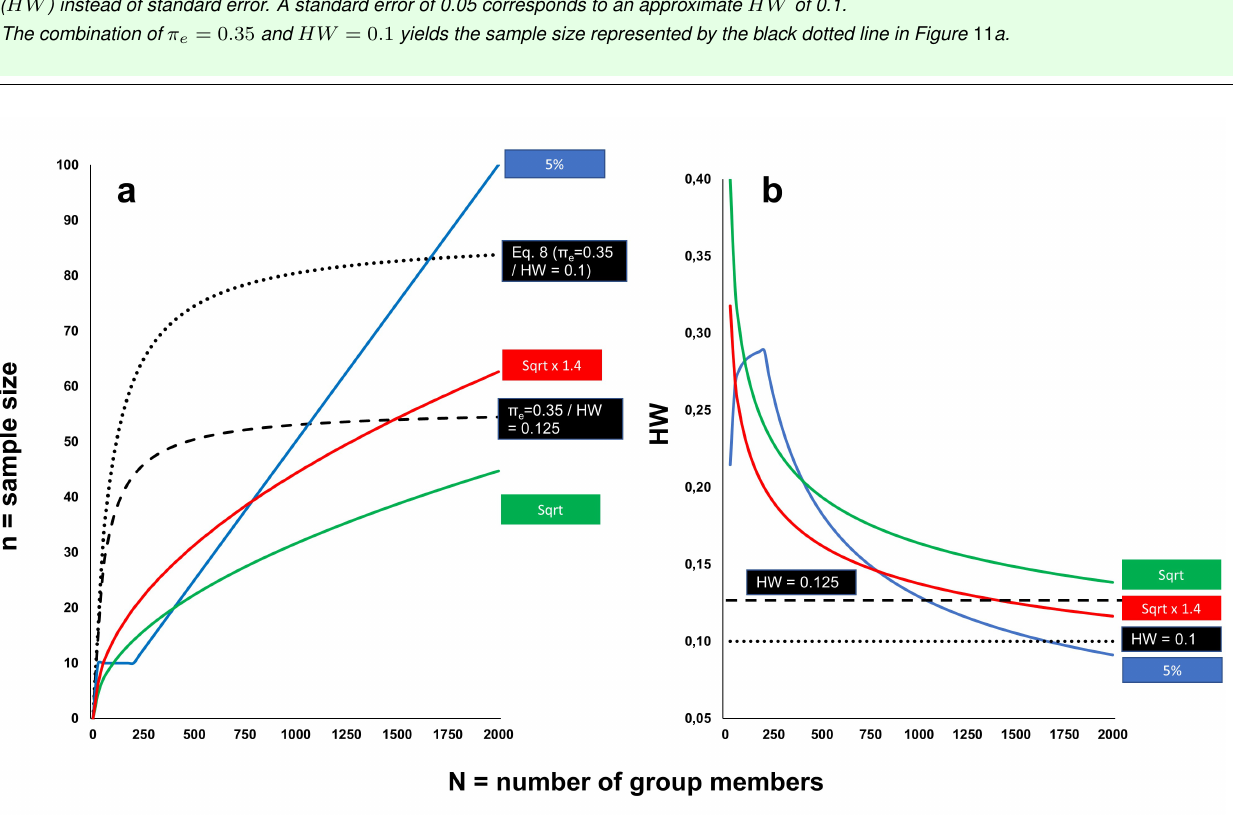
Figure 11. (a) Sample sizes plotted against group members, for four different procedures. The lines for 5%, square root, and square root multiplied by a risk factor 1.4 are the same as shown in Figure 2, but here presented in contrast to the sample size resulting from Equation 11 (black dotted line). The required sample for small groups is much bigger than with any of the other methods, while for a group of 2,000 members, it is slightly lower than the sample size required when using the 5% rule. (b) HW plotted against group members, for the same four methods. HW for Equation 11 is a horizontal line, because this is how it is defined. If we remember that HW = s.e. × 1.96 (Equation 9), this means that the accepted standard error is the same for all group sizes. If we look at the green curve for square root, we see that for a group of 20 farmers, HW is 0.41, for a group of 100 farmers, it is 0.29—meaning that we are ready to accept that 20 or 15% of NCs, respectively, slip through. The line for the 5% takes an irregular form in both (a) and (b), because according to [3] for groups with less than 200 farmers, the rules described in the caption to Figure 2 apply. Therefore, the HW reaches its highest point with 200 members, and then drops. This means that an NC in a 2,000 member group is three times more likely to be spotted than in a 200 member